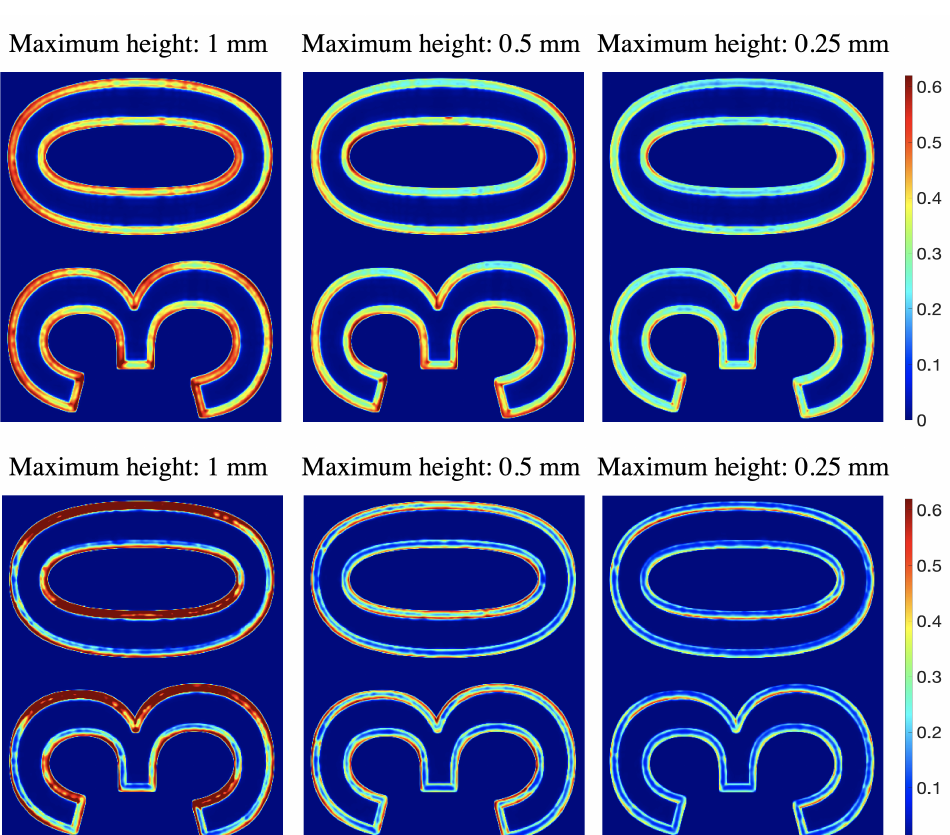
Figure 11. iCID’s lightness structure (mean) quality maps from the MS ( top ) and the SS ( bottom ) captures. It detected more differences on the edges in the 1 mm maximum height print compared to other two prints in both set-up captures. The maps were cropped for illustration purpose. Zero means there is no difference.